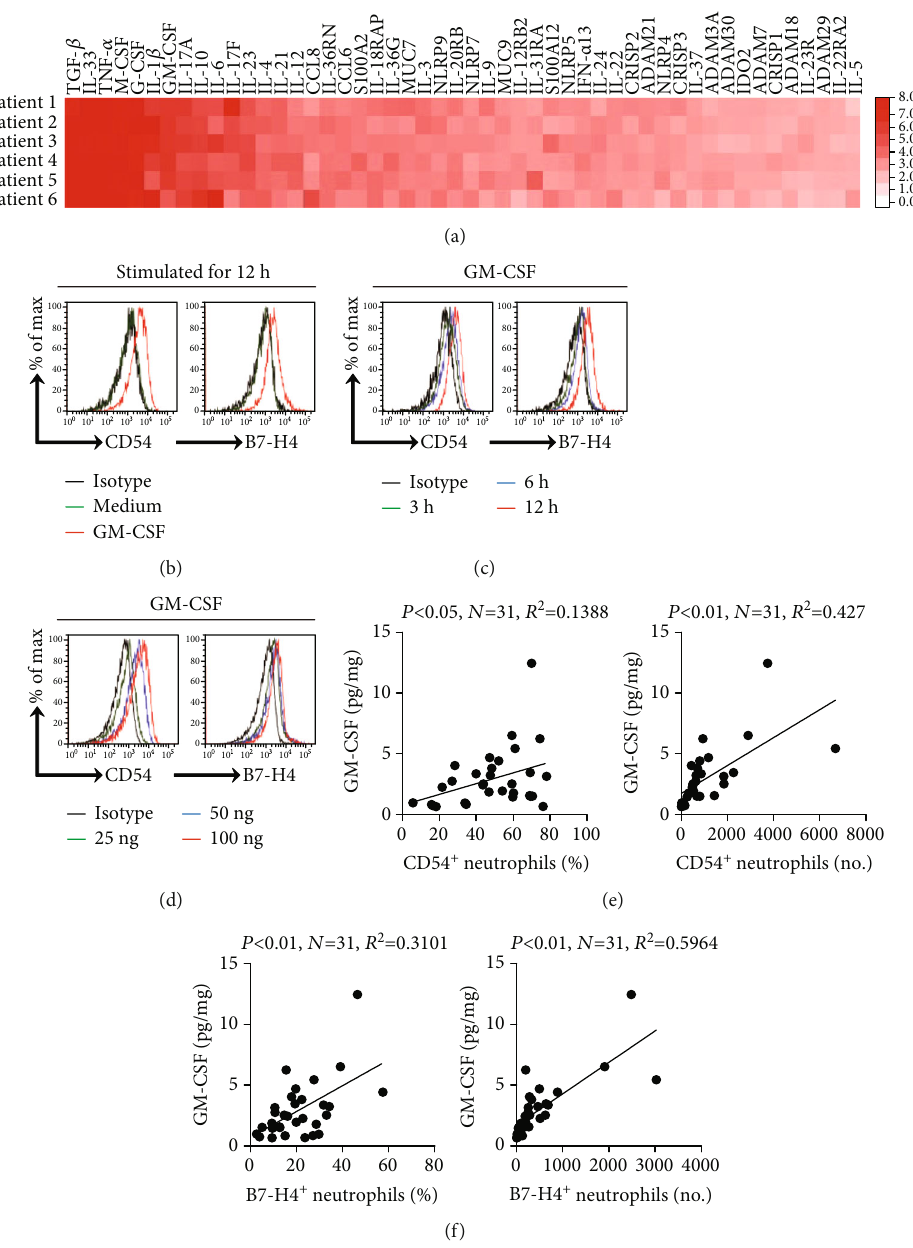
Figure 4: GM-CSF activates neutrophils and induces B7-H4 expression on neutrophils. (a) Clustering of microarray data for the expression of 50 proin fl ammatory cytokine genes in human tumor tissues from 6 GC patients. (b) Expressions of CD54 and B7-H4 on neutrophils exposed to GM-CSF (100ng/ml), or to medium control for 12h. Black: isotype control. (c) Expressions of CD54 and B7-H4 on neutrophils exposed to GM-CSF (100ng/ml) for 3, 6, or 12h. Black: isotype control. (d) Expressions of CD54 and B7-H4 on neutrophils exposed to GM-CSF (25, 50, or 100ng/ml) for 12h. Black, isotype control. (e) The correlations between GM-CSF and CD54 + neutrophils in GC tumors were analyzed. Results are expressed as the percentage of CD54 + neutrophils in neutrophils or the number of CD54 + neutrophils per million total cells and GM-CSF concentration in GC tumor tissues. (f) The correlations between GM-CSF and B7-H4 + neutrophils in GC tumors were analyzed. Results are expressed as the percentage of B7-H4 + neutrophils in neutrophils or the number of B7-H4 + neutrophils per million total cells and GM-CSF concentration in GC tumor tissues. Each dot in (e) and (f) represents 1